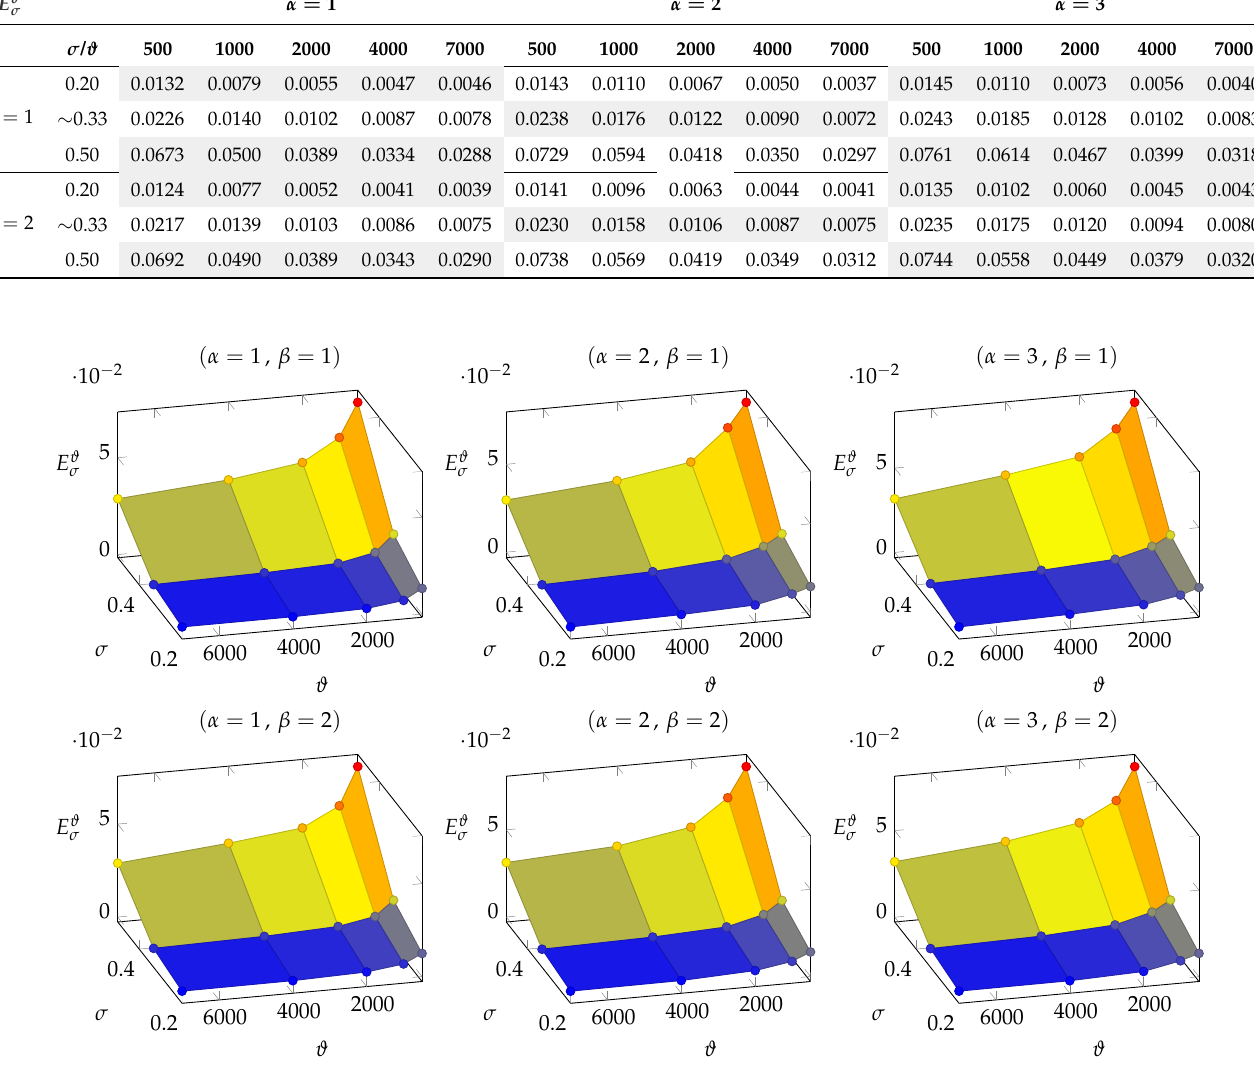
Figure 8. DFN395. Three-dimensional plot of the E ϑ σ values, varying ( σ , ϑ ) ∈ Σ × Θ , for each NN of architecture A α trained with configuration β , for each α = 1,2,3, and for each β =